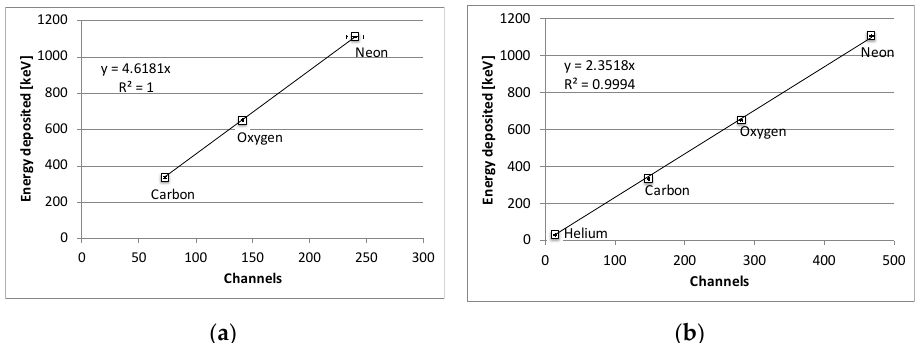
mushroom microdosimeter with low gain settings when located behind 10 mm PMMA (Gaussian fitting (red line) of the carbon portion is shown.).